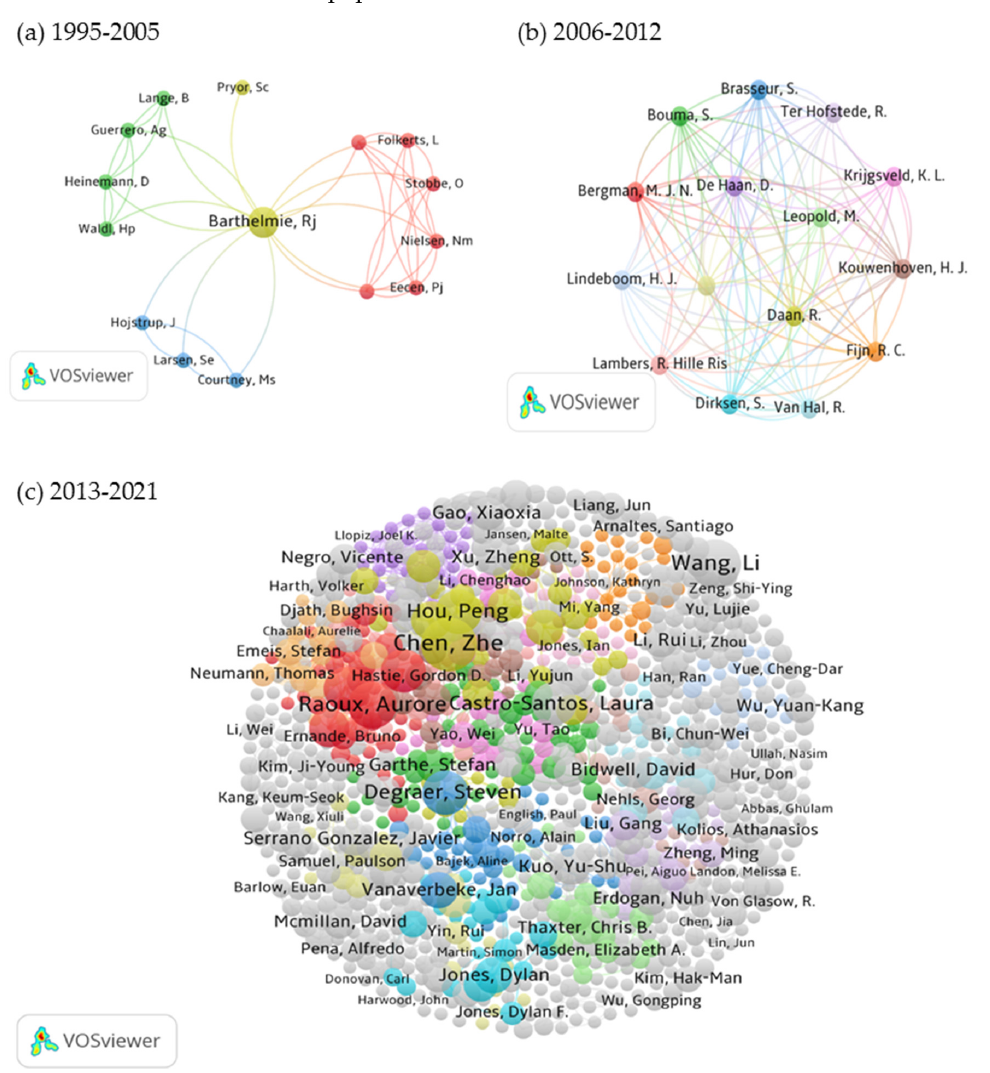
Figure 5. The author cooperation networks for offshore wind farm research: ( a ) first stage, ( b ) second stage, and ( c ) third stage.